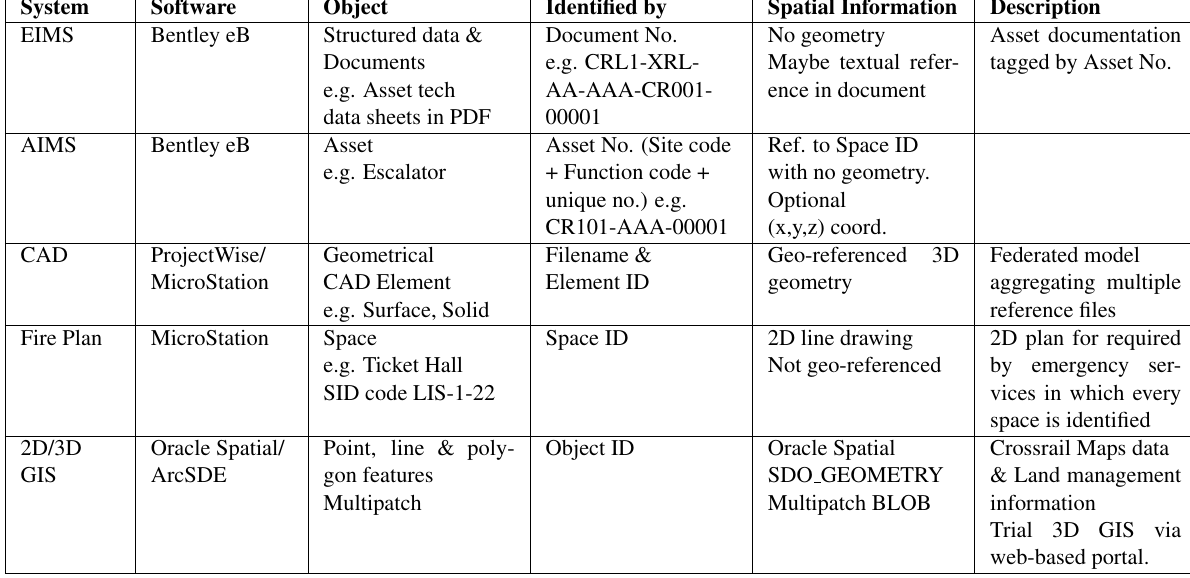
Table 2. Crossrail Information Systems